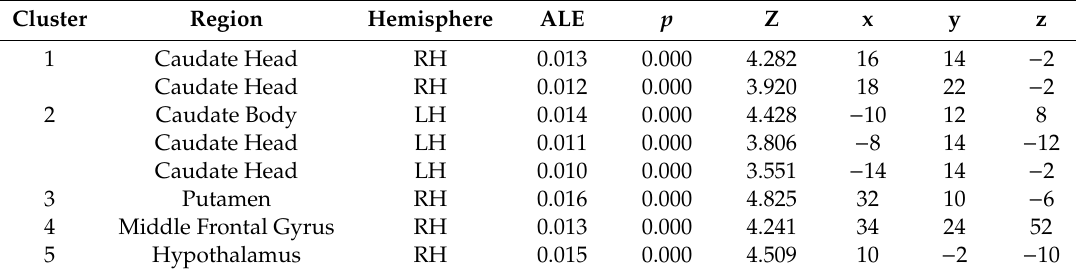
Table 3. Results of ALE meta-analysis on activation in Gambling Disorder. For each cluster region label, the hemisphere, ALE value, p and z values, and MNI coordinates are provided. LH = left hemisphere; RH = right